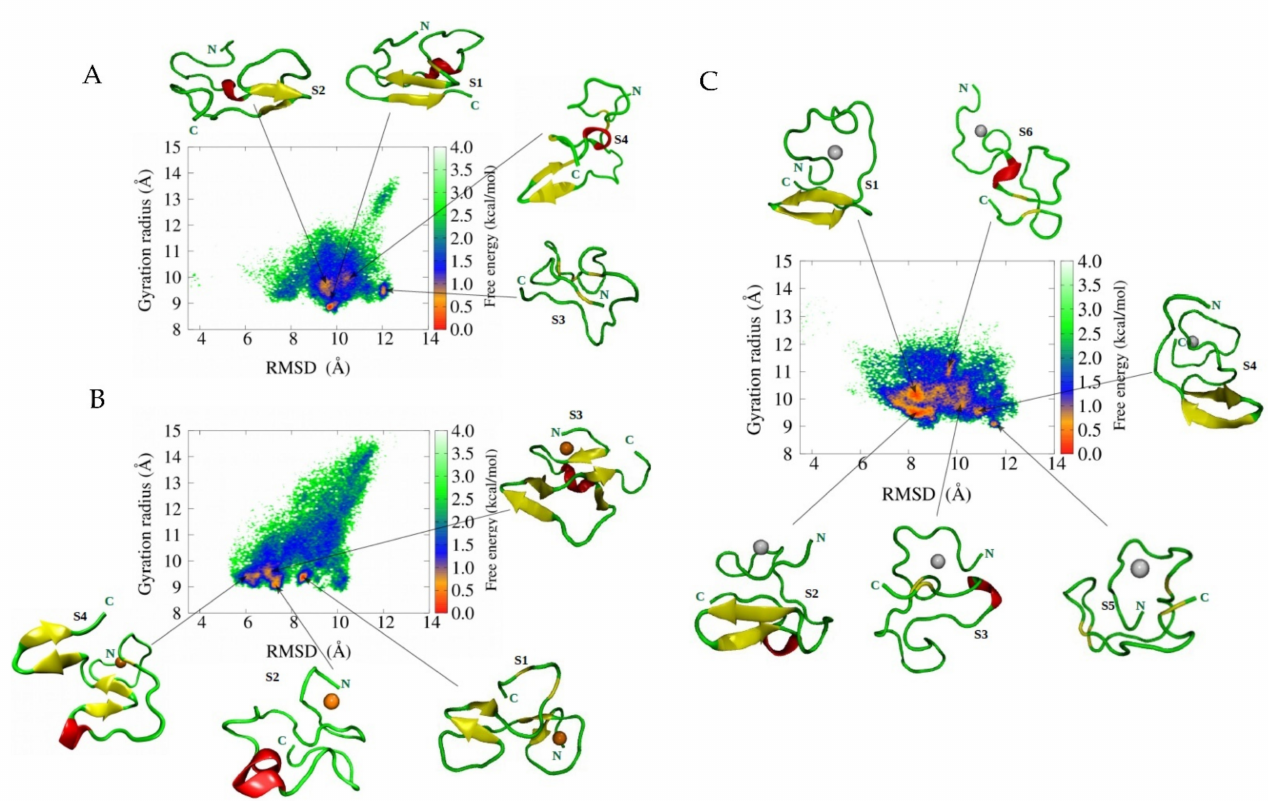
Figure 4. Free energy landscape for ( A ). A β 42, ( B ). A β 42-Cu 2+ , and ( C ). A β 42-Zn 2+ peptides as a function of RMSD and the gyration of radius. Results are based on the whole ensemble of trajectories. Representative structures in the free energy minimum basins are displayed. Reproduced with permission from the work of Boopathi et al. [98]. Copyright 2020 John Wiley and